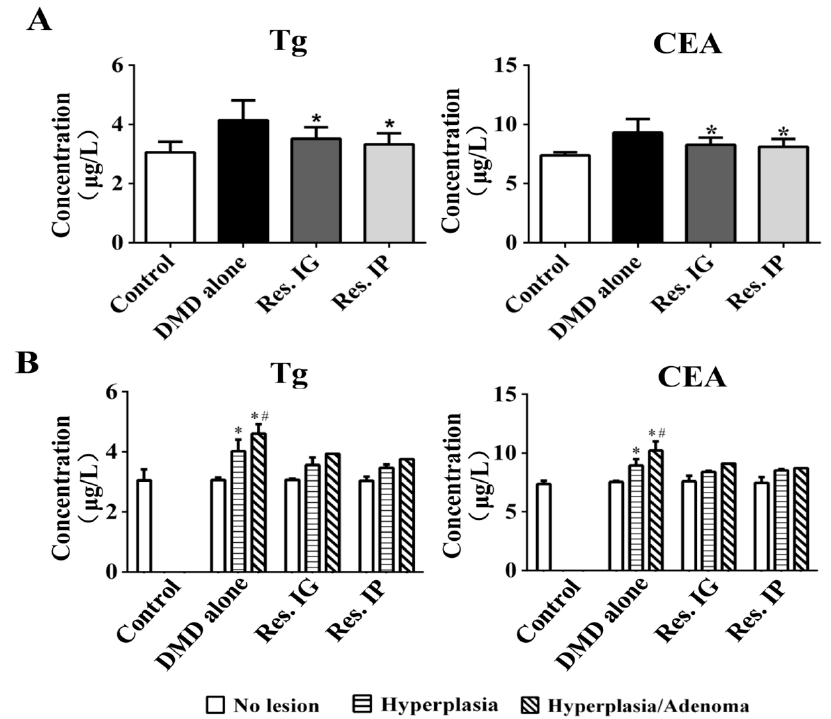
Figure 4. ELISA determination of Tg and CEA levels in rat serum. ( A ) The average serum Tg and CEA levels in the four experimental groups. *, p < 0.05 compared with DMD alone Group; ( B ) The average serum Tg and CEA levels in the rats of the same experimental groups without and with pathological lesions. *, p < 0.05 compared with lesion-free rats; #, p < 0.05 as compared with the rats with hyperplasia.